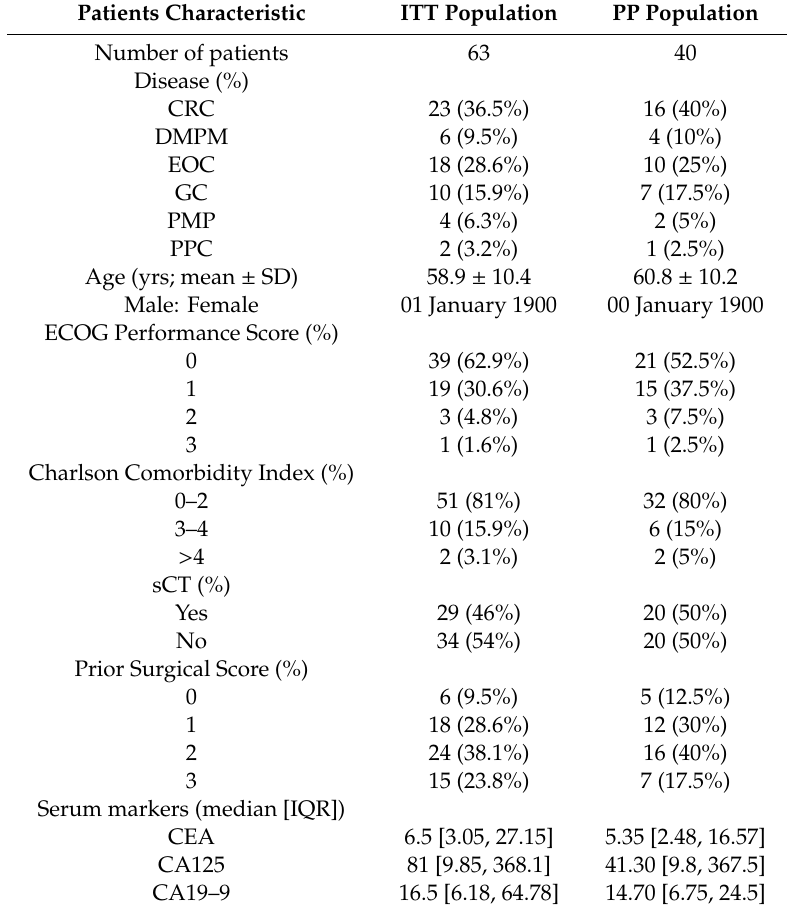
Table 1. Patients features undergoing pressurized intraperitoneal aerosol chemotherapy (PIPAC)